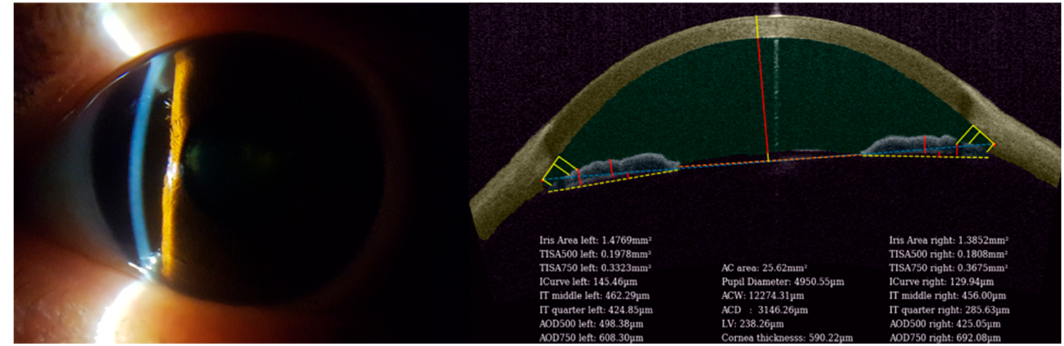
Figure 2. A sample image obtained from the MIDAS instrument and its corresponding anterior segment optical coherence tomography image.